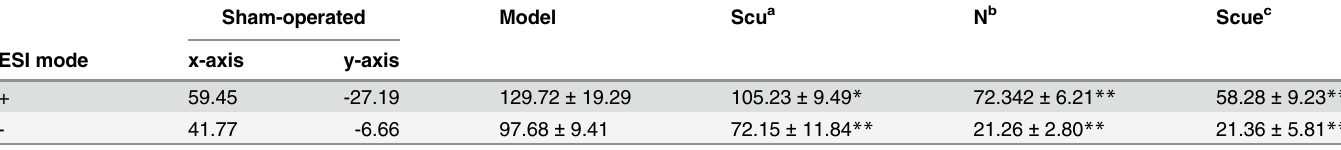
Table 3. The relative distance from the PLS-DA scores plot between treatment and sham-operated group urine samples in ESI mode.